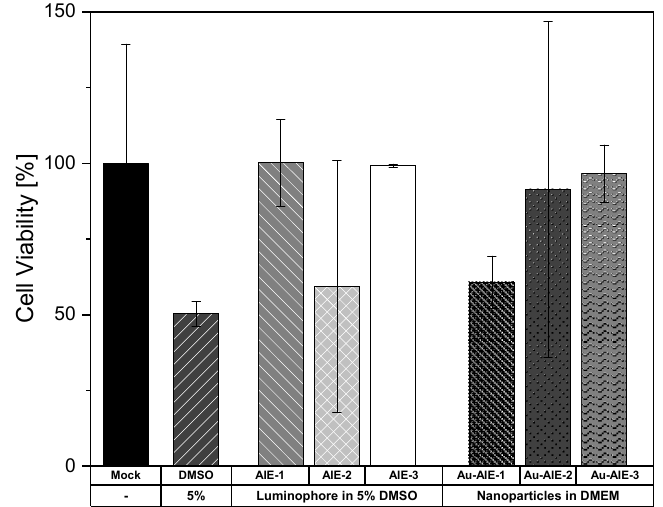
Figure 5. MTT cell viability assay with HeLa cells, incubated with water-dispersed Au-AIE gold nanoparticles ( Au-AIE-1 , Au-AIE-2 , Au-AIE-3 ) and with dissolved AIE luminophores (in 5% DMSO). Data represent the mean of three individual experiments with the standard deviation.